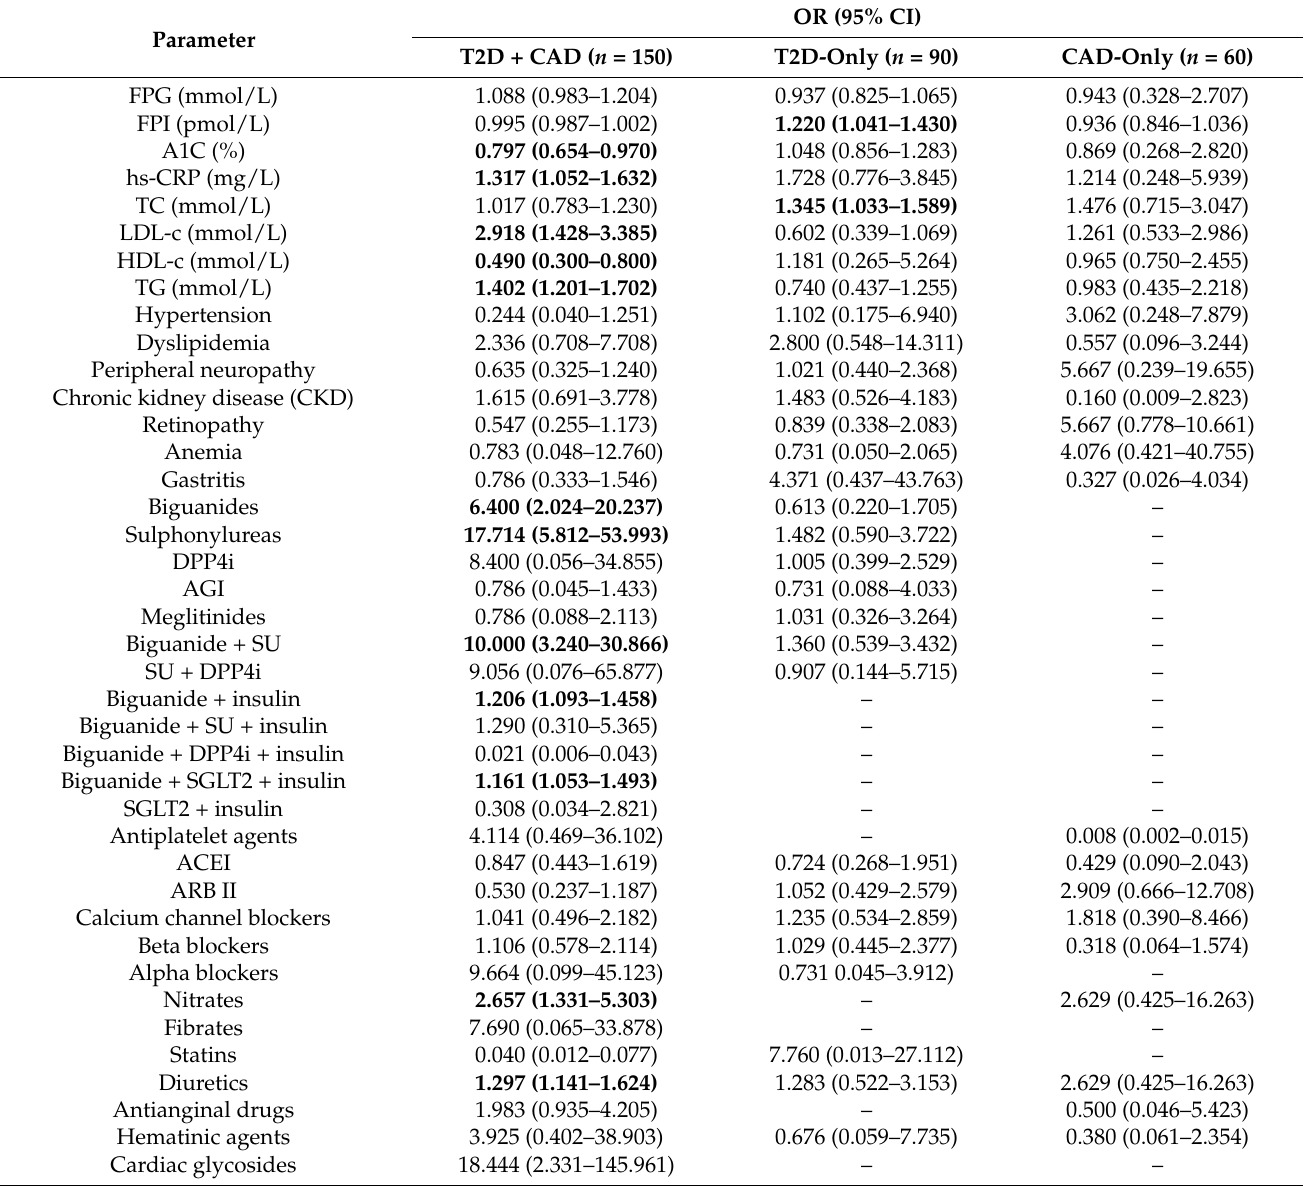
Table 1. Association of clinical factors of study population with RBP-4